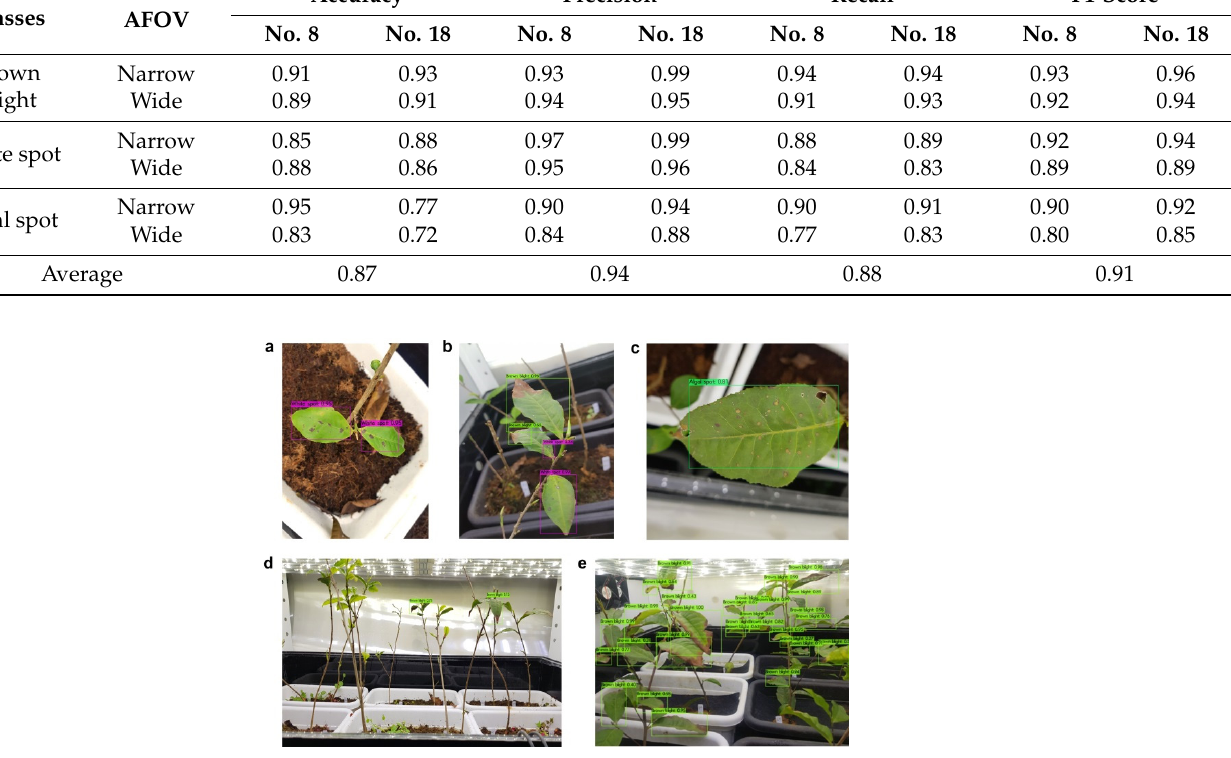
Table 3. Performance evaluation of each class for tea plants (Taicha No. 8 and No. 18).